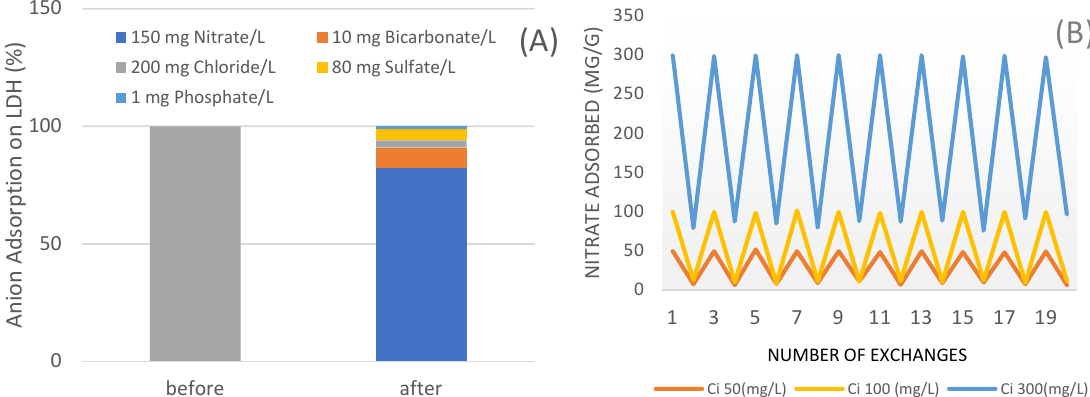
after Fig. 5: (A) Mechanisms of anion adsorption on Mg-Al-LDH (4:1) in the stimulated soil solution (B) Nitrate adsorption and desorption on Mg-Al-LDH (4:1) in concentrations of 50, 100, and 300 mg/L ( Table 2). In the Mg-Al-LDH (4:1)-soil mixture, the nitrate removal percentage was 73.64%, showing a little difference (approximately 2%) with the simulated soil solution